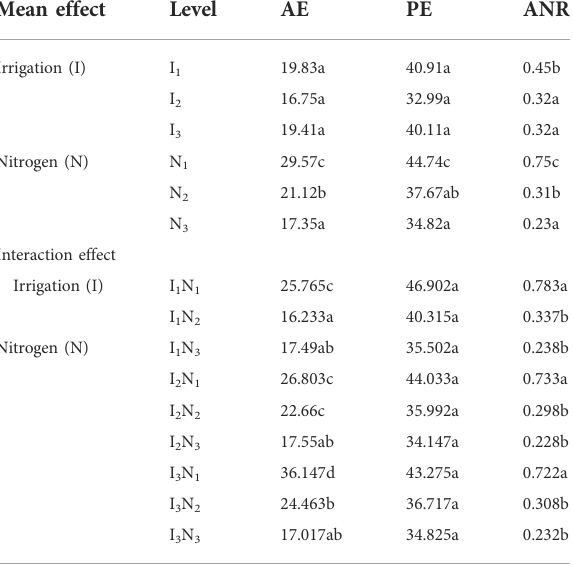
TABLE 3 Agronomic ef fi ciency (AE), physiological ef fi ciency (AE), and apparent nitrogen recovery (ANR) in wheat crops (pooled analysis).